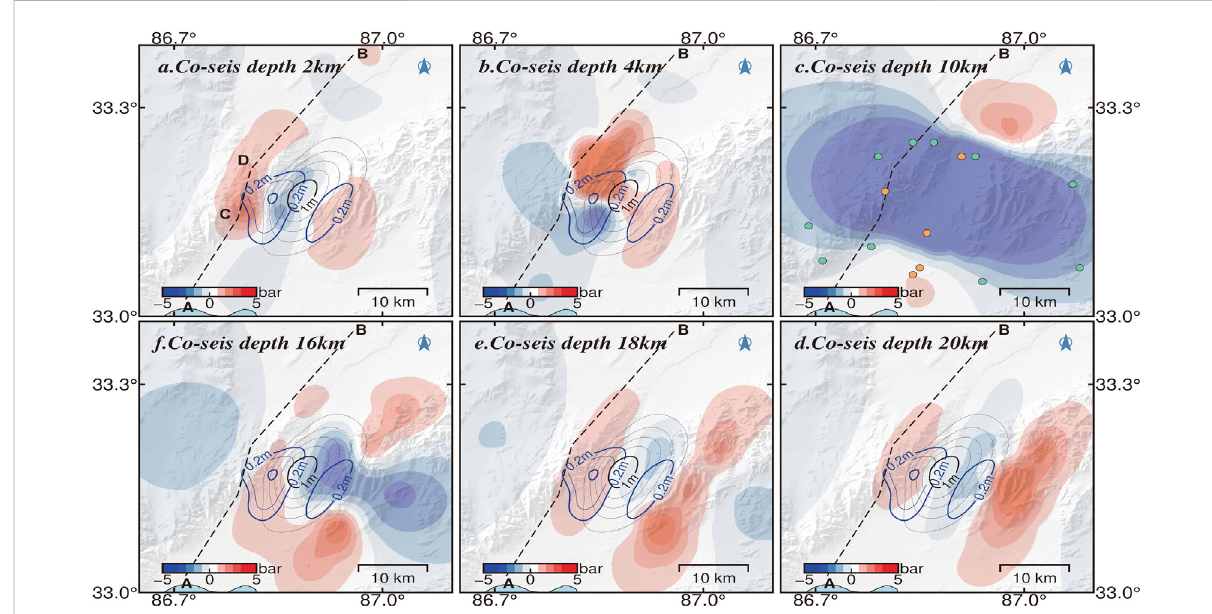
FIGURE 9 Coseismic Coulomb stress changes at different depths for the 2020 Nima earthquake. The dotted line AB indicates the seismogenic fault. The black (0.2 m interval) and blue (0.1 m interval) lines indicate the coseismic and postseismic slip isoline projected on the surface, respectively. The green and yellow circles represent the latter aftershocks of 4 ≥ M ≥ 3 and ≥ 4,